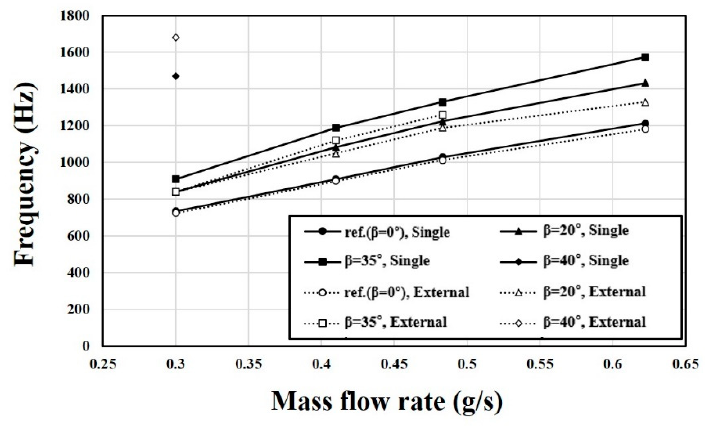
Figure 13. Comparison of jet frequency variation with mass flow rate between the cases with and without external flow for various bending angles.